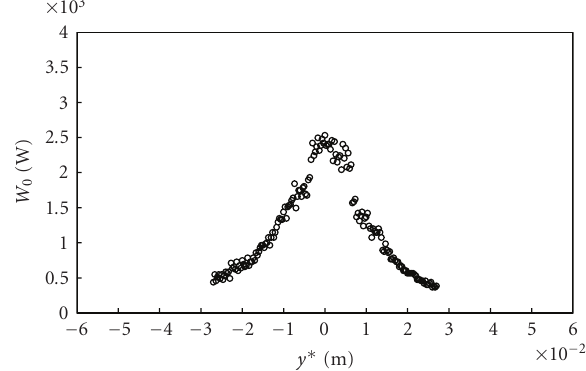
Figure 9: Variation of heat flow from the arc into the calorimeter in no imposed magnetic field.